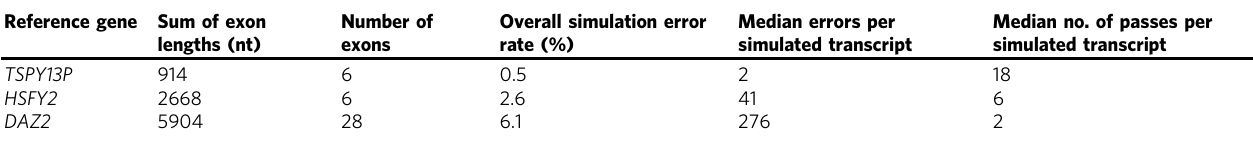
Table 1 Simulated data information. Gene sequences (taken from the corresponding reference gene in Ensembl) and their corresponding PacBio CCS error rates used for simulation. We simulated multigene families by using these gene sequences at the root. We refer to the resulting gene families by using the name of the reference gene, sometimes dropping the last modi fi er (i.e . TSPY instead of TSPY13P